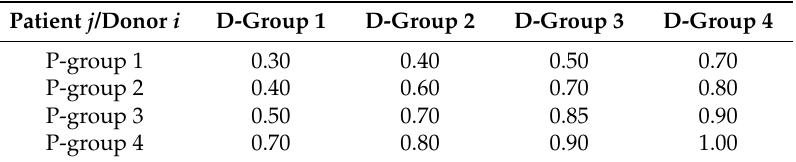
Table 1. The level of compatibility based on health status.